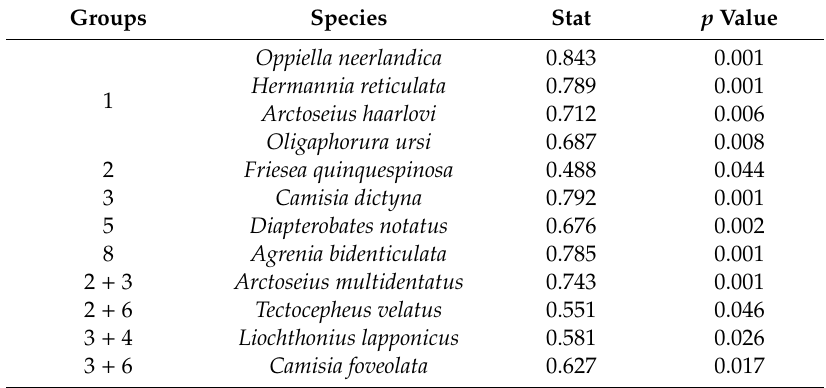
Table 3. Species that are characteristic of a group of sites revealed using indicator species analysis. Groups Species Stat p Value